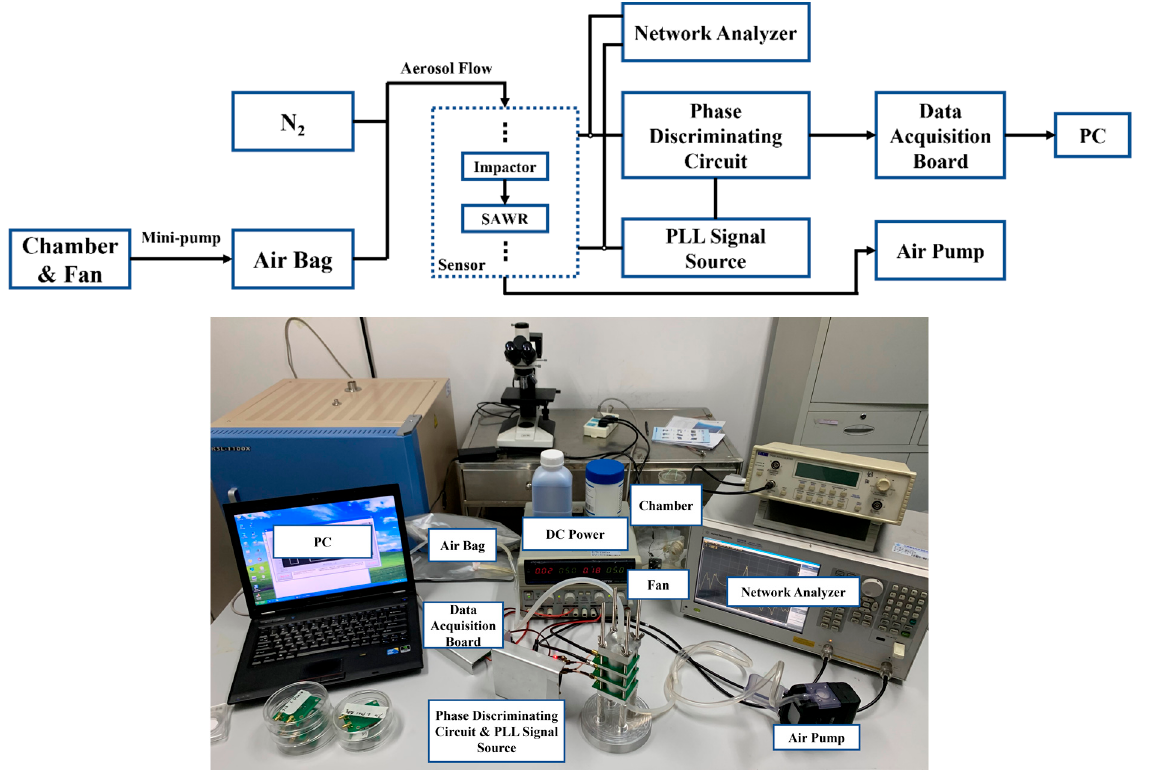
Figure 13. Schematic and photograph of the experimental setup.